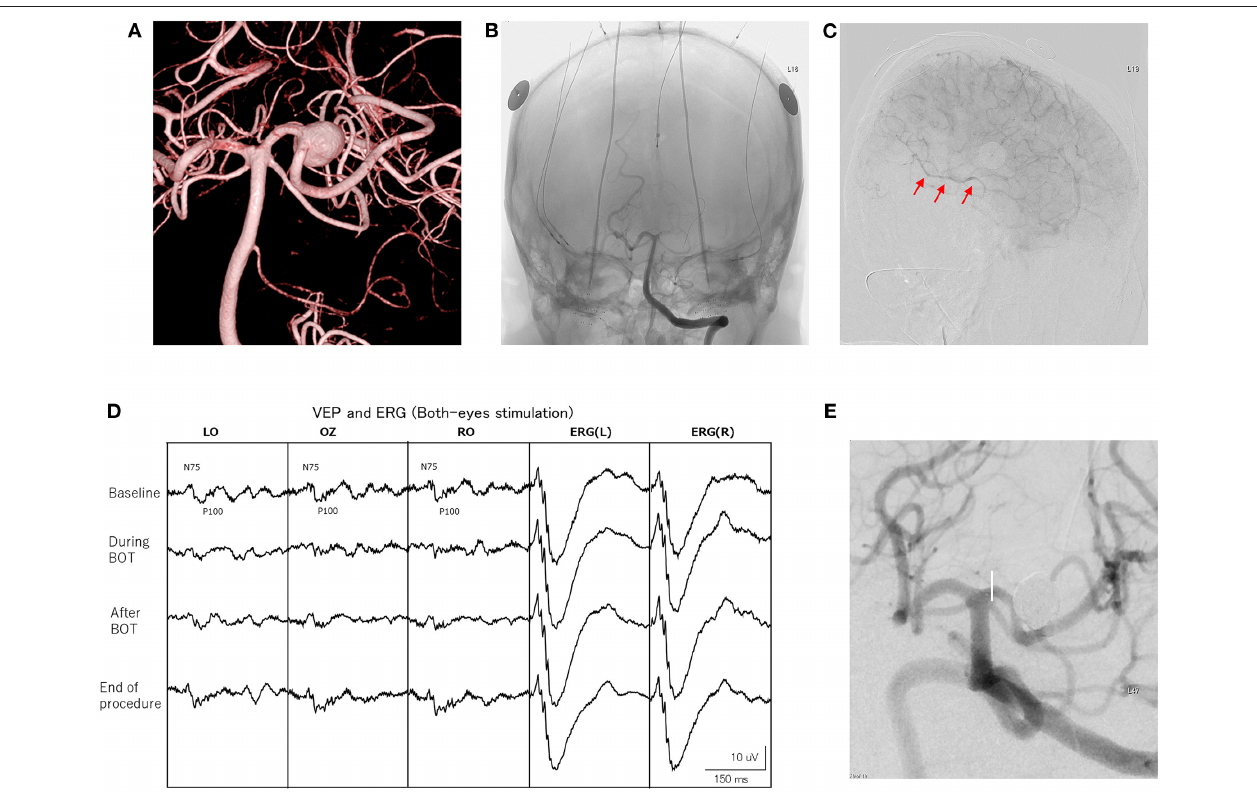
FIGURE 2 | Findings for a 57-year-old woman. (A) Imaging shows a left large posterior cerebral artery (PCA) aneurysm (10mm). (B) Left vertebral angiography depicts electrode settings for VEP, ERG and MEP monitoring. A balloon-microcatheter is positioned in the left PCA (P2A portion), then balloon occlusion test (BOT) is performed for 10min. (C) During BOT, left internal carotid angiography shows retrograde collateral filling of the distal PCA territory. This is also confirmed by ipsilateral internal carotid angiography (arrows). (D) A significant decrease in VEP amplitude is seen during BOT. The amplitude of VEP completely recovers after the end of BOT. (E) Stent-assisted coil embolization of the aneurysm is performed under VEP and MEP monitoring.